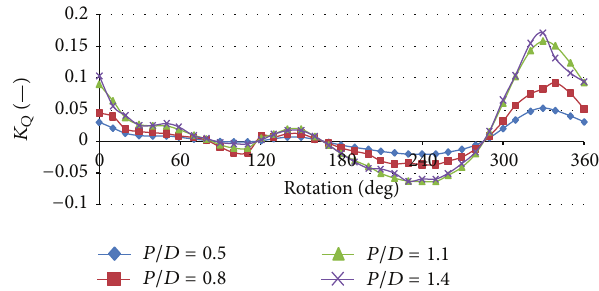
Friction forces are calculated based on given formulae.